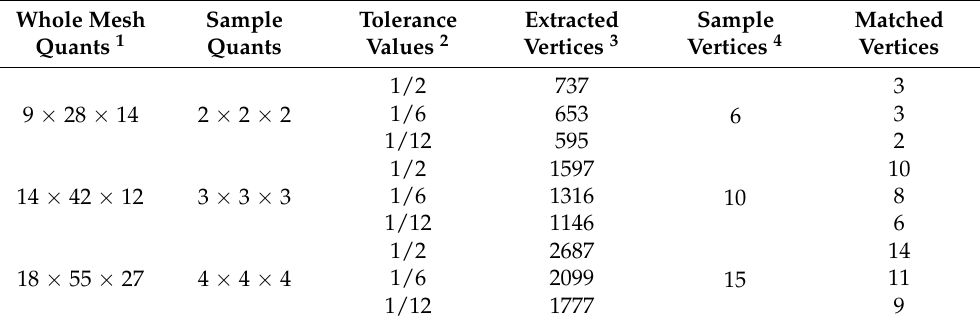
Table 2. Matching accuracy depending on quantization levels and extraction tolerance.